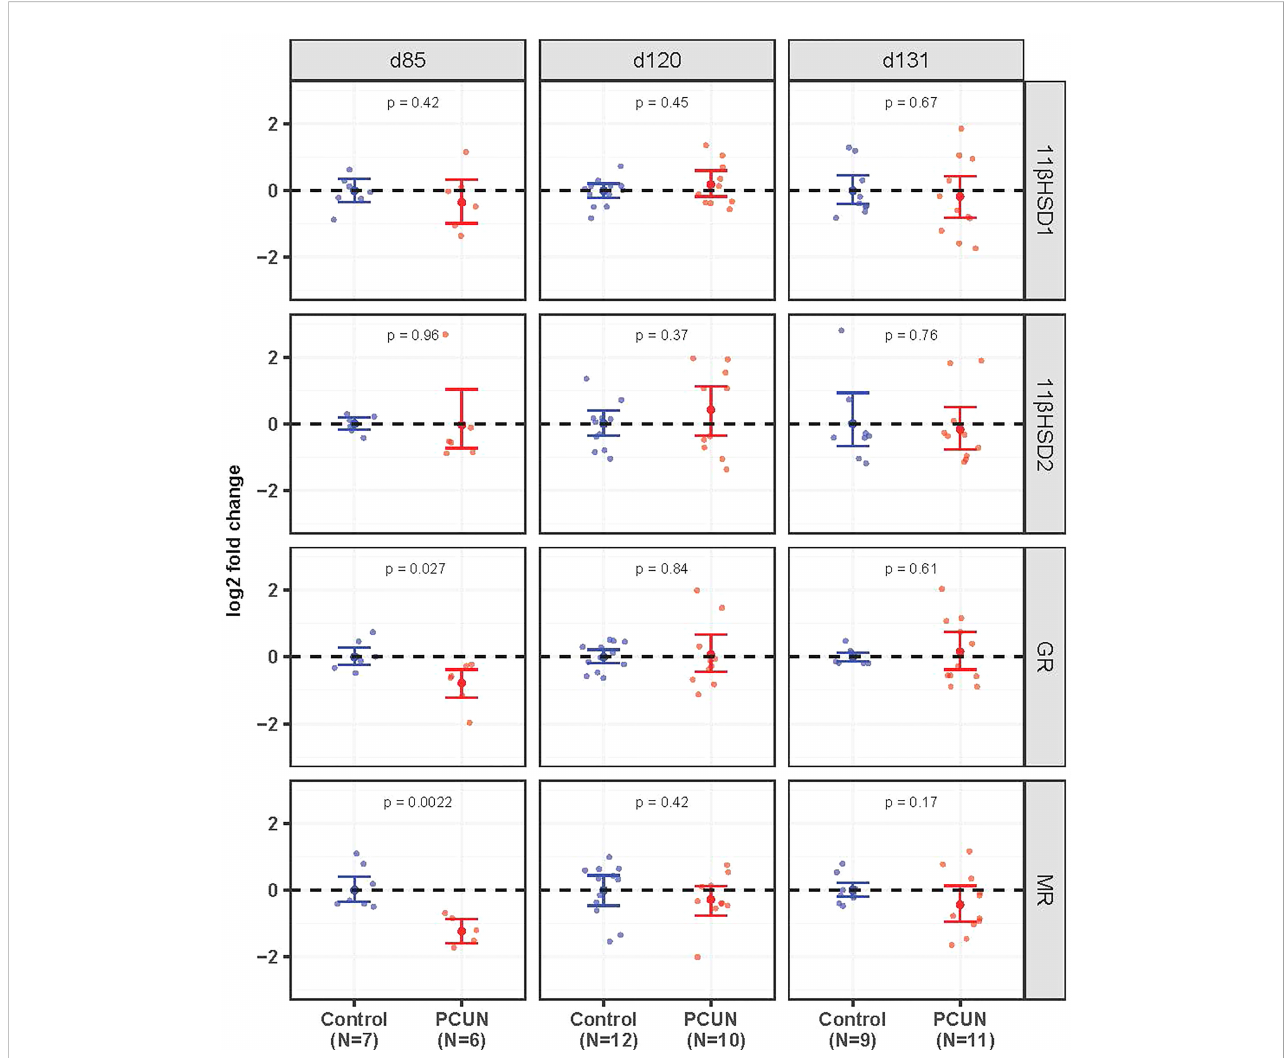
FIGURE 2 Fetal hippocampal mRNA expression. Log 2 fold change of 11 b HSD1 , 11 b HSD2 , GR and MR mRNA expression levels in PCUN (symbol in red) in comparison to N (symbol in blue) based on real-time PCR analysis in the fetal hippocampus. Data are shown as mean ± 95% con fi dence interval. Symbols represent individual animals. Student ’ s t-tests were used to assess statistical difference, with signi fi cance de fi ned as p <